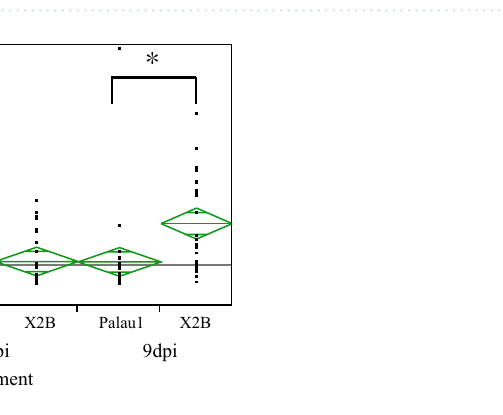
Figure 3. Viral copies in 1 ng total DNA extracted from Japanese larvae injected with OrNV Palau1 isolate and OrNV-X2B isolate, respectively. Center lines of green diamonds indicated average copy number, and a length between upper and lower point of diamond indicate the 95% confidence interval. Between two strains at each time points, the viral copies of OrNV-X2B were significantly higher than those of OrNV-Palau1 at 9 dpi (Steel– Dwass test, Z = 3.460, p = 0.0071: * indicated significant